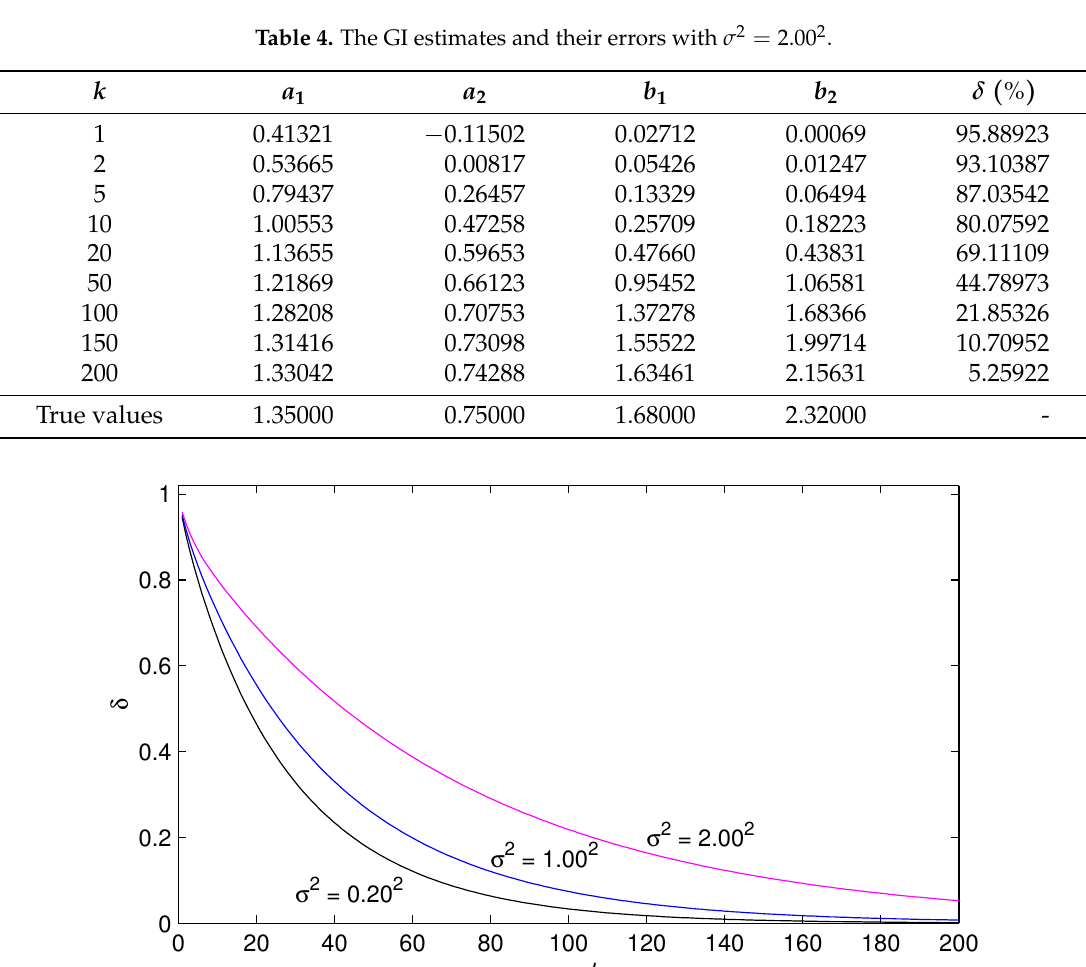
Figure 4. The GI estimation errors δ versus k with σ 2 = 0.20 2 , σ 2 = 1.00 2 and σ 2 = 2.00 2